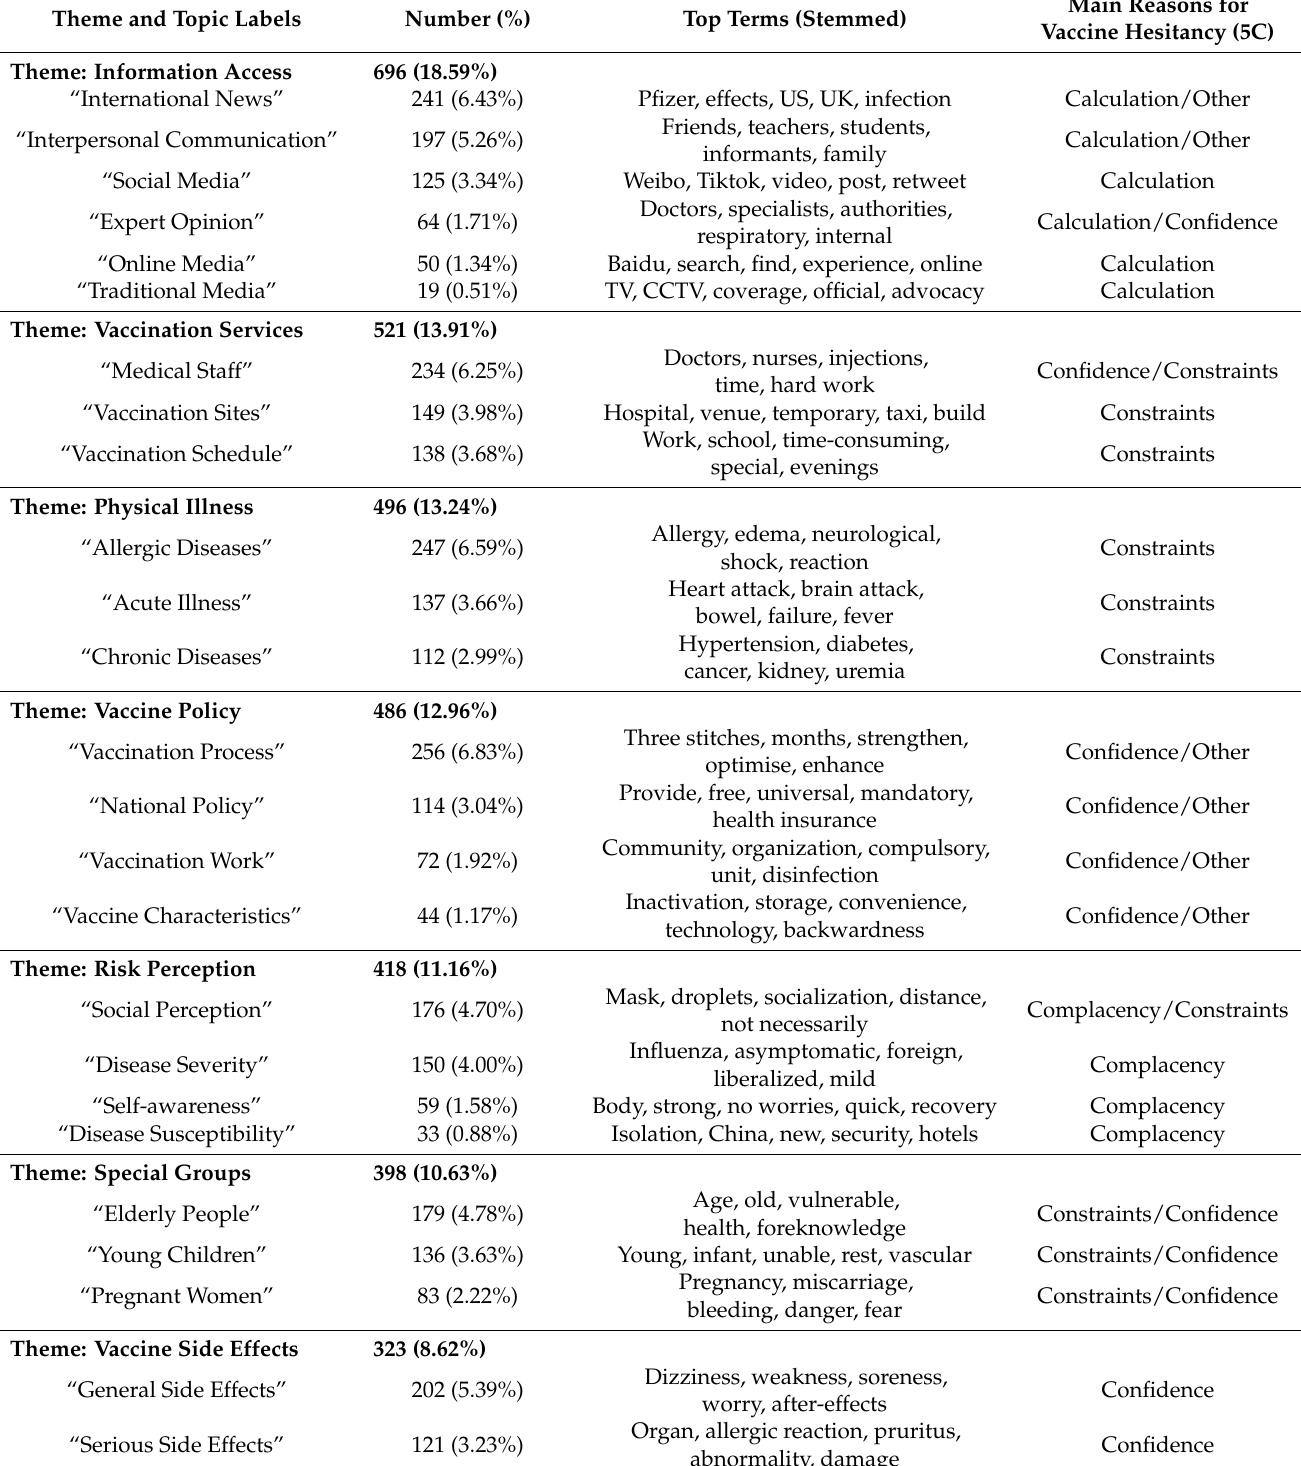
Table 1. Themes and Topics in Sample